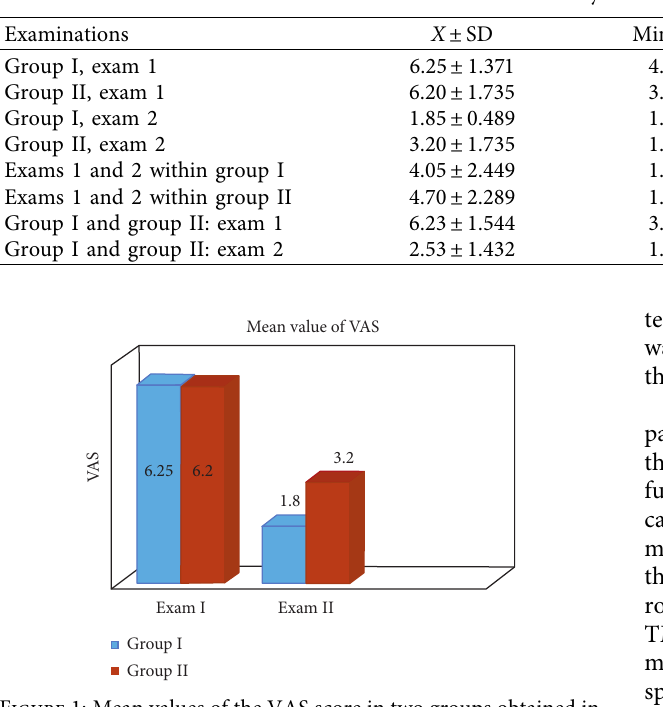
Table 2: The result of statistical analysis of masticatory muscles pain evaluation.